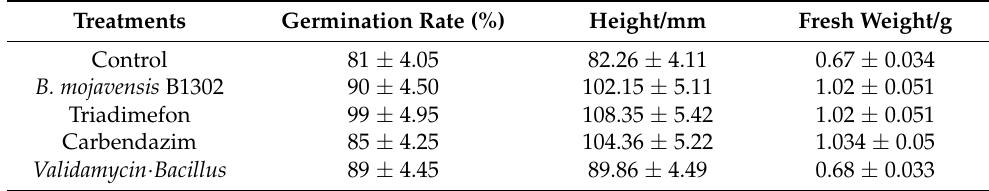
Table 7. Promotion of different treatments on the growth of wheat